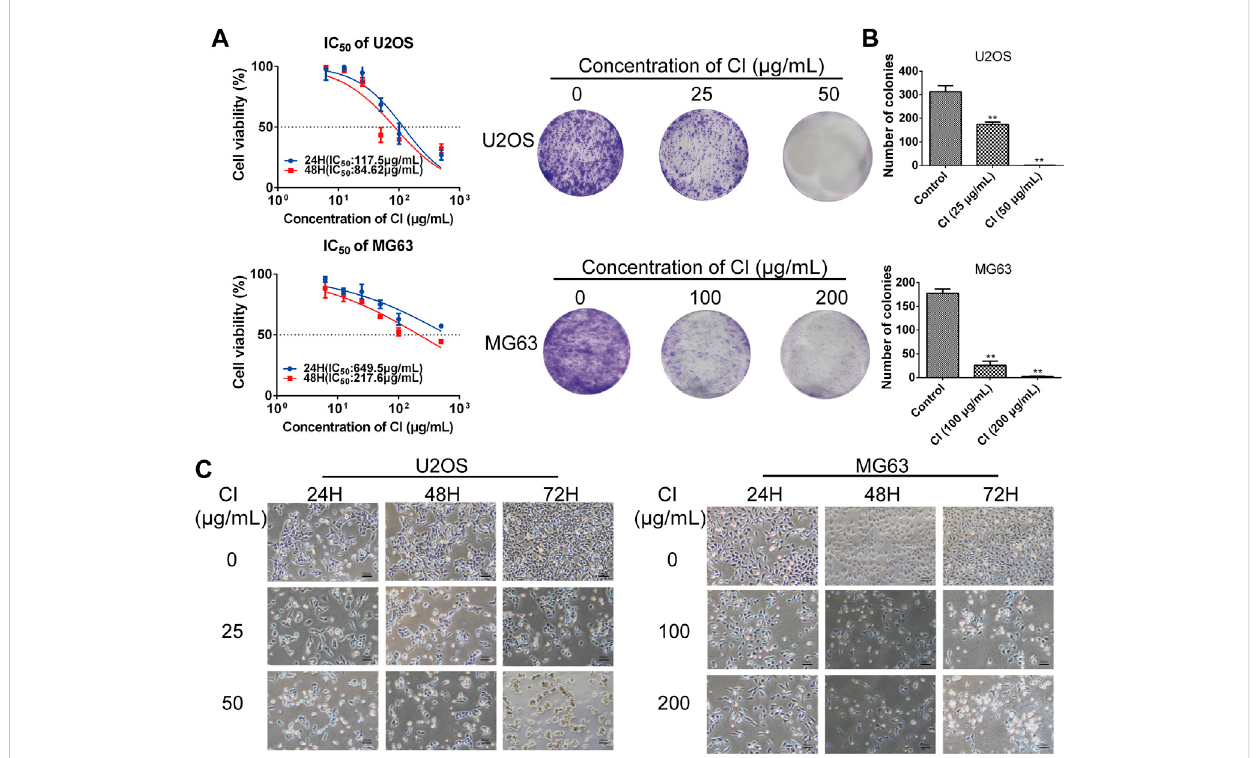
FIGURE 2 CI reduces cell viability of OS cells. (A) After 24, 48 h treatment with CI, the IC 50 is 117.5 μ g/mL, 84.62 μ g/mL in U2OS cells and 649.5 μ g/mL, 217.6 μ g/mL in MG63 cells. Results were presented as the mean ± SEM of three independent experiments. (Non-linear Regression) (B) Colony formation assay of U2OS and MG63 cells exposed to CI (0, 25, 50 or 0, 100, 200 μ g/mL) for 14 days. The colony numbers ( > 50 cells/colony) were calculated manually. Results were presented as the mean ± SEM of three independent experiments. * p < 0.05, ** p < 0.01 vs . control group (one-way ANOVA). (C) Morphological changes of U2OS and MG63 cells were treated with CI (0, 25, 50 or 0, 100, 200 μ g/mL) for 12, 24 and 48